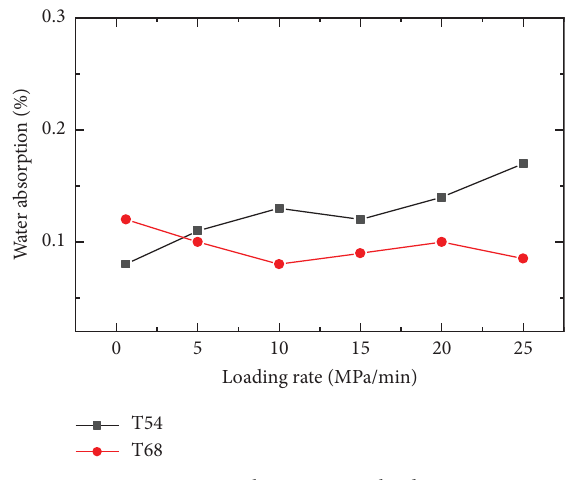
Figure 9: Water absorption vs. loading rate.